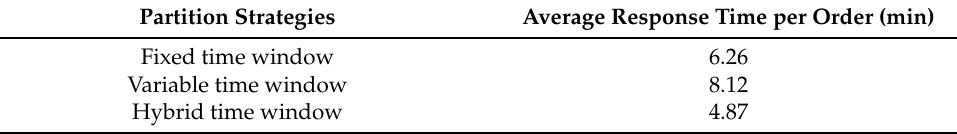
Table 4. Average response time per order.